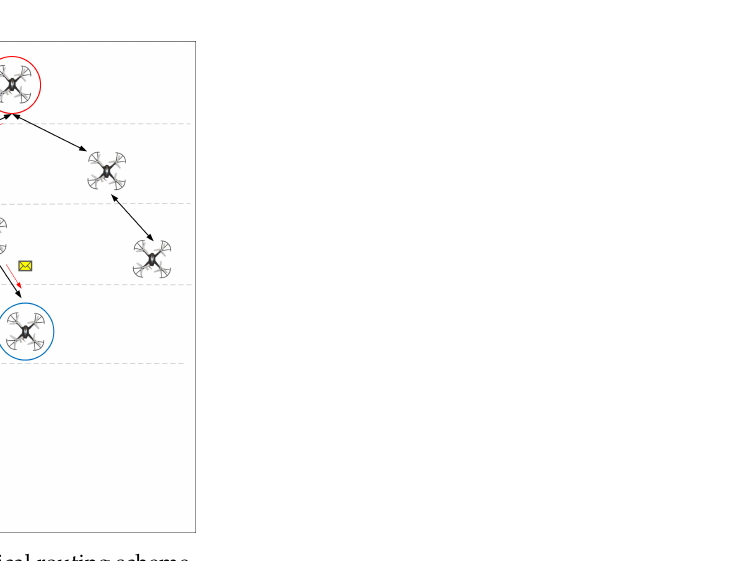
Figure 15. Hierarchical routing scheme.